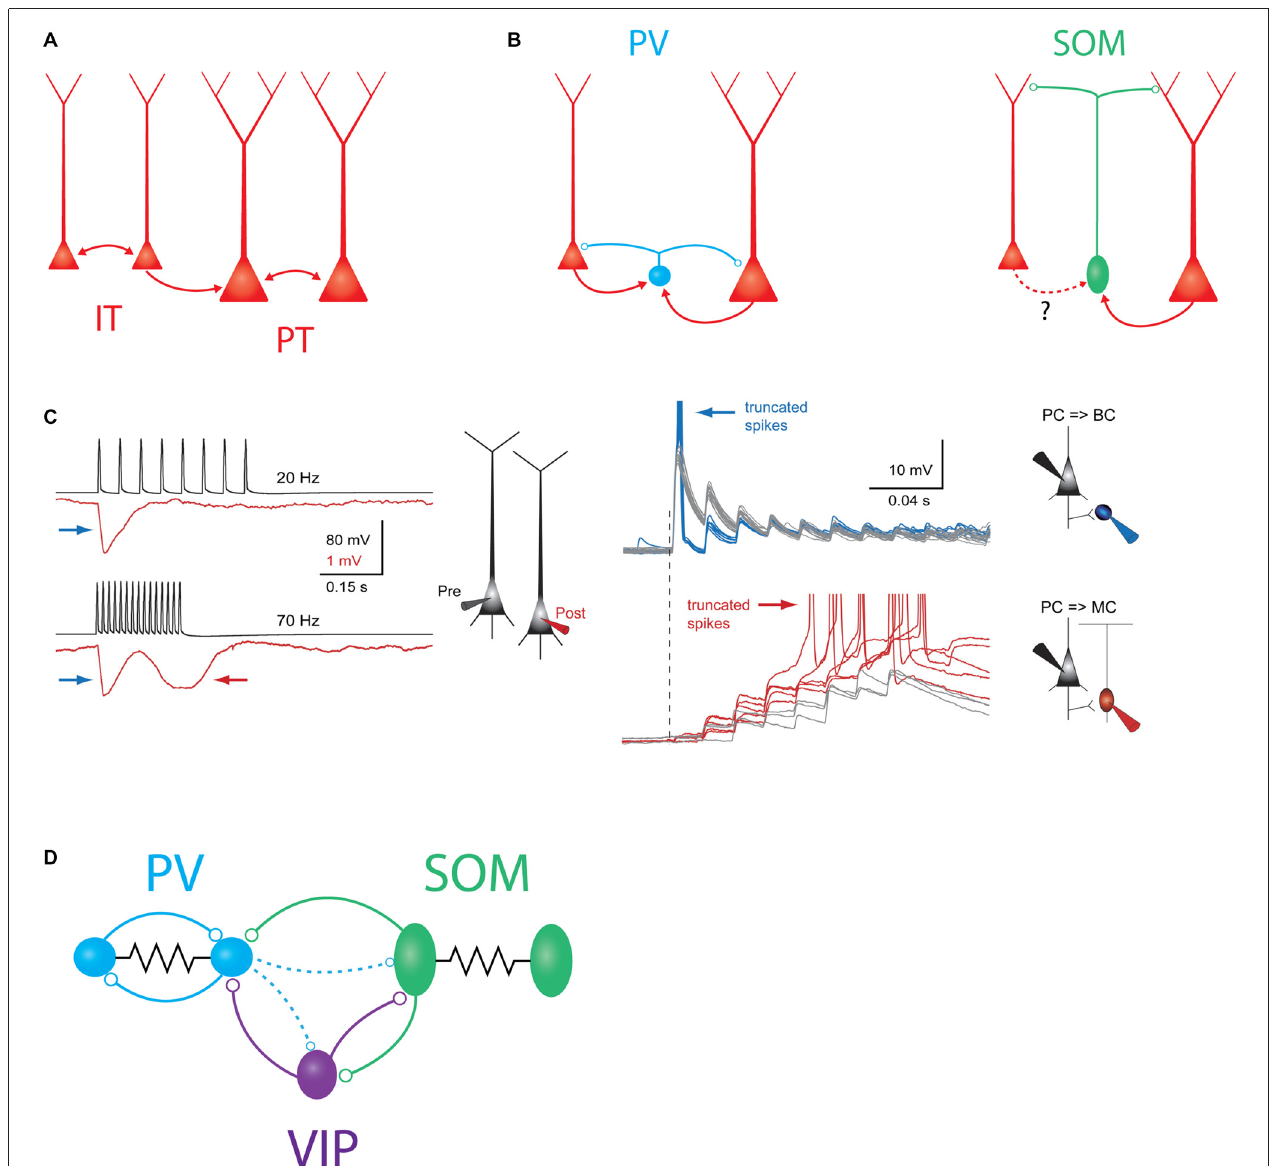
FIGURE 1 | Schematic overview of major intralaminar circuits in layer 5 (L5). (A) Both the slender-tufted intratelencephalic (IT) cells (left) and thick-tufted pyramidal tract (PT) cells (right) form homotypic excitatory synaptic connections. IT cells additionally connect to PT cells, but PT cells connect to IT cells only very rarely. IT → IT and IT → PT connections both occur at a fairly high rate (Brown and Hestrin, 2009; Lefort et al., 2009; Kiritani et al., 2012). PT → PT connectivity occurs less frequently, but is structured into strongly interconnected subnetworks (Song et al., 2005; Perin et al., 2011). (B) Left: both IT and PT cells (red) excite parvalbumin (PV) cells (blue) and receive perisomatic inhibition from PV cells (Angulo et al., 2003; Silberberg and Markram, 2007; Kruglikov and Rudy, 2008). Right: somatostatin (SOM)/Martinotti cells (green) inhibit the distal dendrites of both PT and IT cells. These interneurons receive excitatory input from PT cells, but it is unknown if IT cells also excite them. (C) Experimental evidence for disynaptic inhibitory circuits between L5 pyramidal cells (PCs). Left: example traces showing two types of disynaptic inhibitory responses in a postsynaptic PC (red) driven by spiking in a presynaptic PC (black). Firing the presynaptic cell at 20 Hz (top traces) drives a transient, frequency-independent disynaptic inhibitory response (indicated by the blue arrow) which is likely mediated by activation of a PV/basket cell at the onset of spiking. Firing the same cell at 70 Hz (bottom traces) reveals a second, frequency-dependent form of disynaptic inhibition (indicated by the red arrow) which is likely due to delayed recruitment of a (SOM) Martinotti cell. Right: membrane potential responses of different interneurons to high-frequency stimulation of an L5 PC. Top: (PV) basket cells receive strong excitatory postsynaptic potentials (EPSPs) at the onset of stimulation, which can drive subthreshold (gray traces) or supra- threshold depolarization (blue traces). In either case, the postsynaptic response is initially strong, but then depresses rapidly. Bottom: EPSPs in Martinotti cells are weak and unreliable at the onset of L5 PC firing, but these facilitate and can eventually drive postsynaptic spiking, leading to frequency dependent disynaptic inhibition (FDDI; gray traces, subthreshold responses, red traces- suprathreshold responses). Reproduced with permission from Silberberg and Markram (2007). (D) Schematic of interneuron-to-interneuron connectivity in L5. PV cells (blue) form reciprocal chemical and electrical synapses with other PV cells. SOM cells are electrically but not chemically connected to other SOM cells, and form chemical synapses onto PV cells and vasoactive intestinal peptide (VIP) cells. VIP cells inhibit PV cells and SOM cells. Dashed lines indicate two weaker outputs from PV cells onto SOM cells and VIP cells.